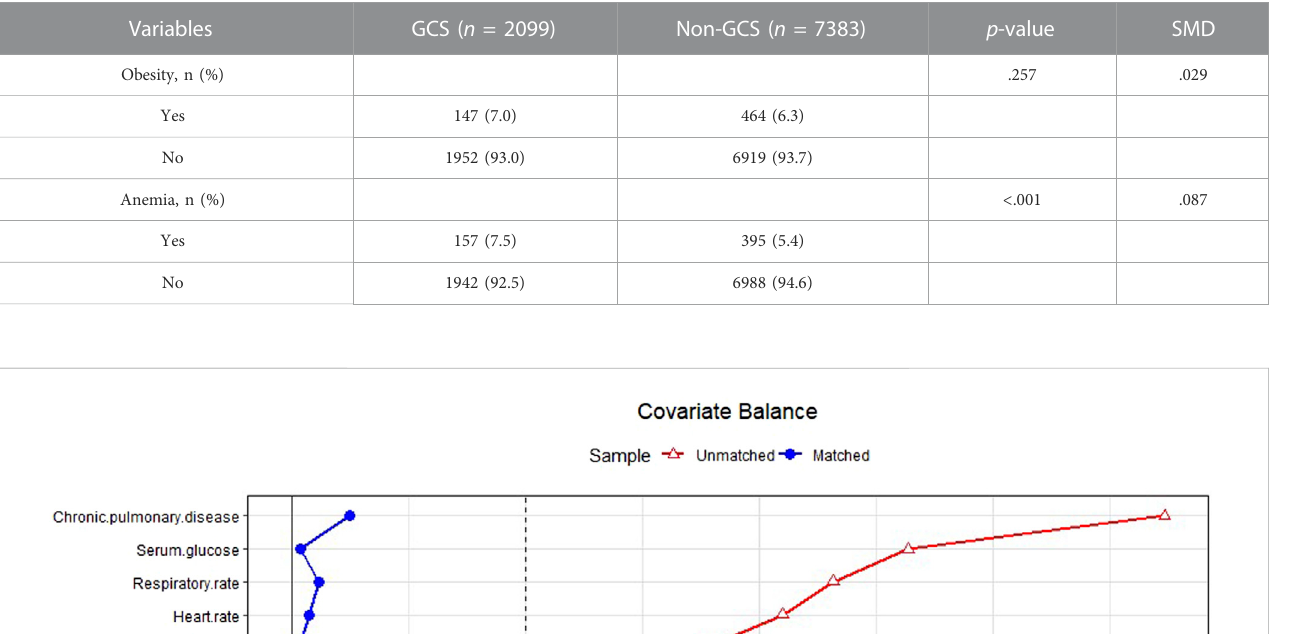
were 2,048 (97.6%) and 7,066 (95.7%), respectively. The WBC and lymphocyte counts were signi fi cantly higher in the glucocorticoid group than in the non-glucocorticoid group. Overall, the baseline characteristics of the two groups of patients were unbalanced for most variables.